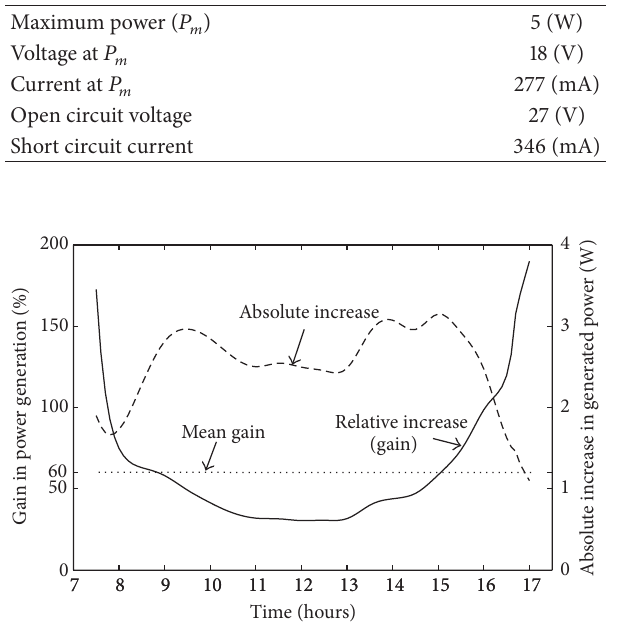
Figure 12: Power generation improvement obtained by using the proposed system (experiment on October 5).